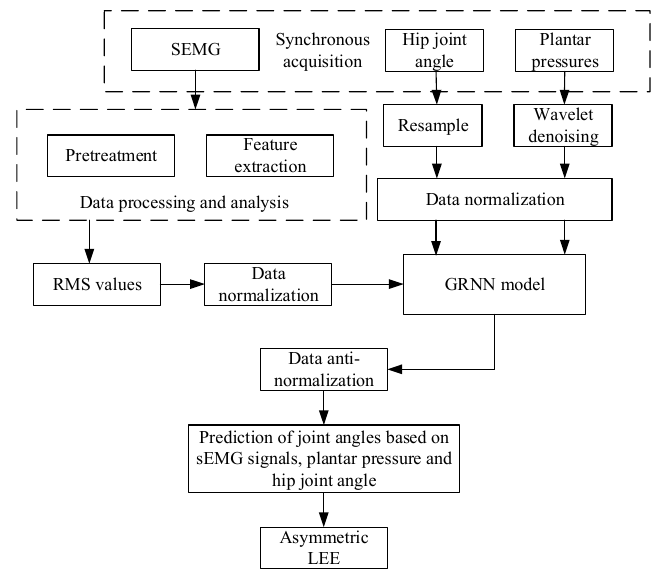
Figure 2. Flow chart of joint-angle prediction.